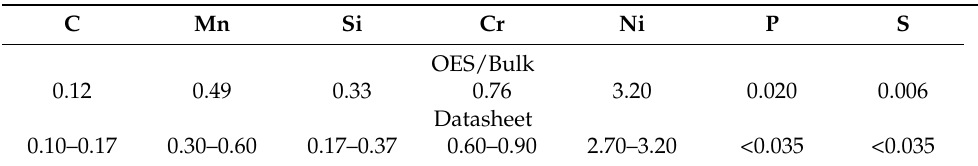
Table 2. Chemical composition of steel equivalent 1.5752 (i.e., CSN 41 6426); instrument: Tasman Q4 Bruker